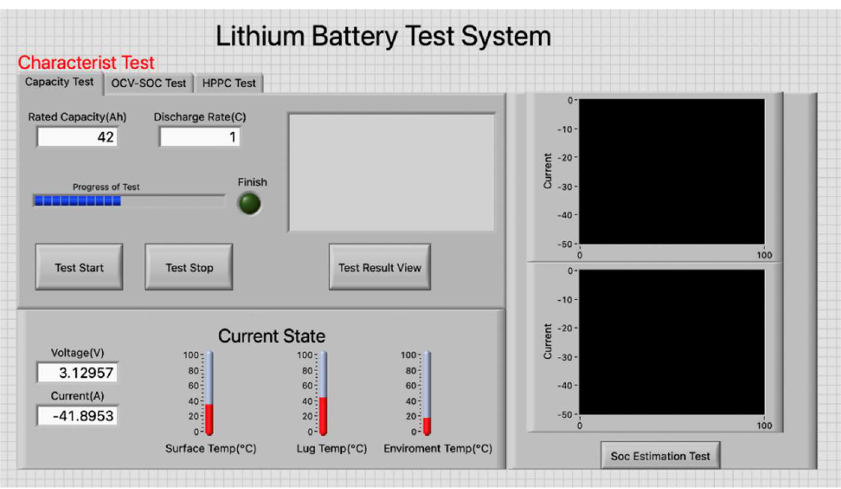
Figure 5. Battery test system interface.